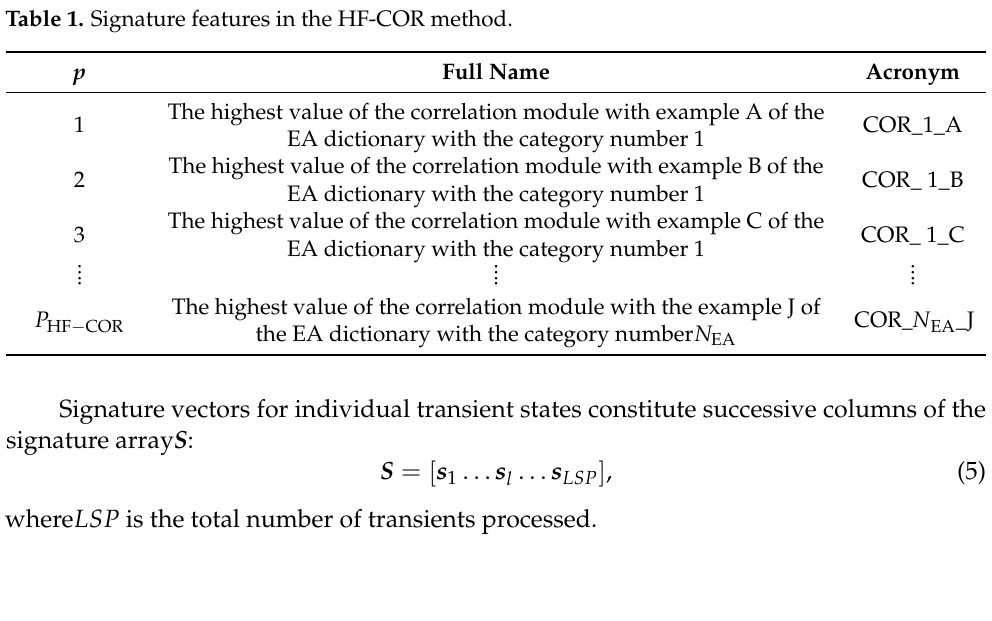
Figure 14. The absolute value of cross-correlation with the maximum value marked for example measurement data. Table 1. Signature features in the HF-COR